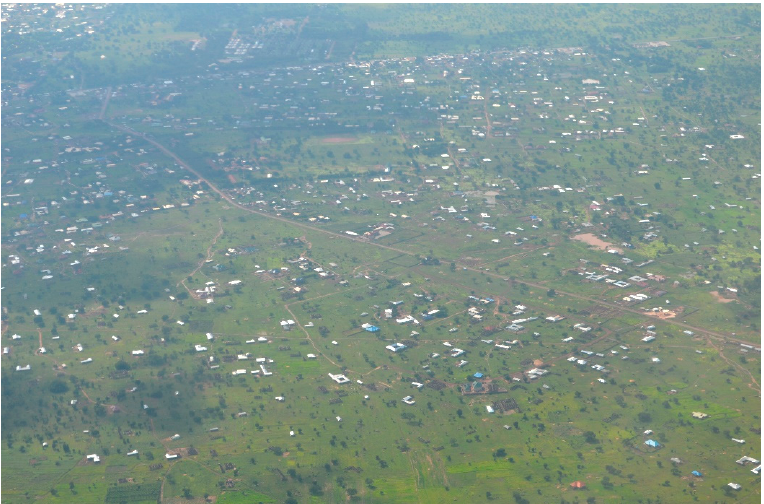
Figure 10. Diffuse sprawl in the north-eastern inner periurban zone, 6.5 km away from Tamale’s city centre (source: Author, 2014). centre (source: Author,